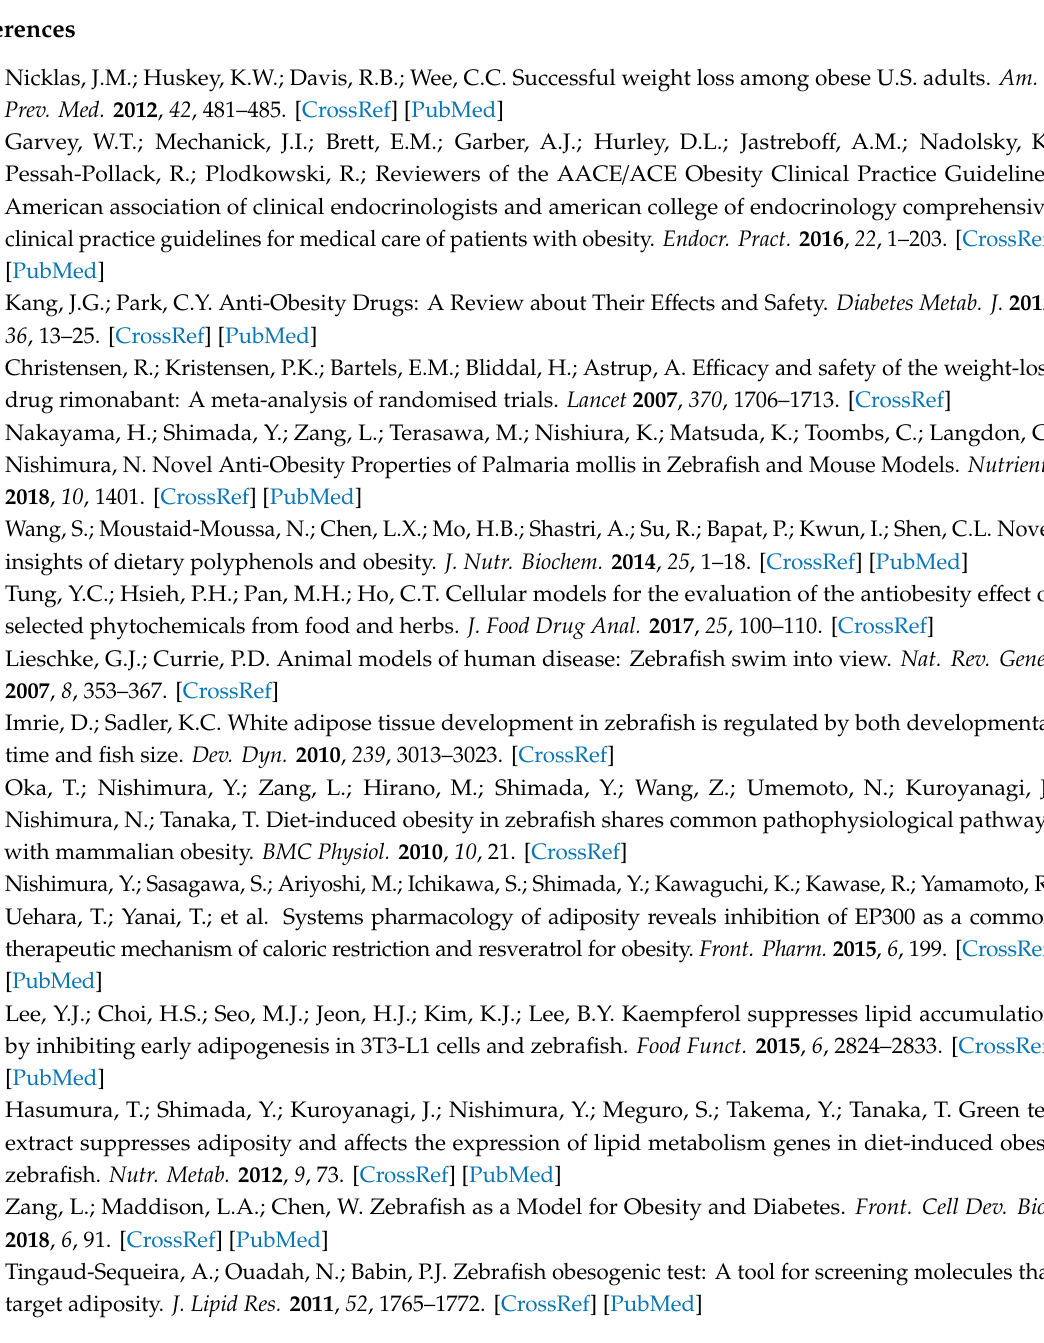
Supplementary Materials: Table S1: NPs used in this